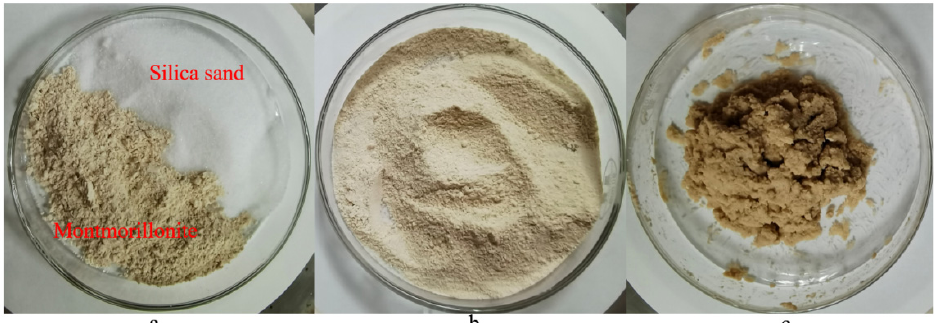
Figure 2. Sediments sample: ( a ) montmorillonite and silica sand; ( b ) mixture of silica sand and montmorillonite; ( c ) after brine was added into the silica sand/montmorillonite mixture.